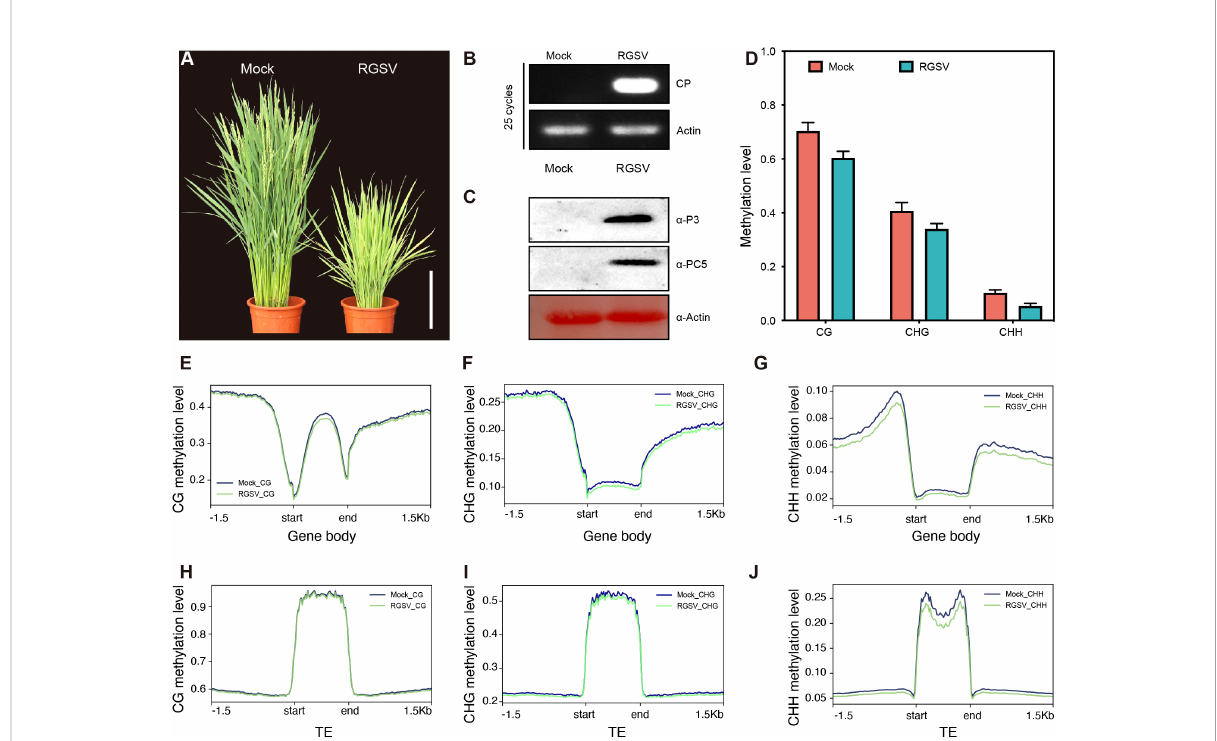
FIGURE 1 Characteristics of methylation genomics of rice infected with RGSV. (A) The signs of the disease induced by RGSV on rice plants. (B) The expression of the RGSV coat protein (CP) gene was measured using qRT-PCR. (C) The viral content in rice leaves infected with RGSV was detected using western blotting with anti-RGSV CP and anti-RGSV PC5 polyclonal antibody. Rice actin was used as the loading control. (D) The frequency histogram of methylation of CG, CHG and CHH types in RGSV infected and uninfected rice. (E – J) Visualization of DNA methylation pro fi les of mCG, mCHG and mCHH peripheral genes and transposable elements (TE S , within 1.5 kb) in RGSV-infected and uninfected